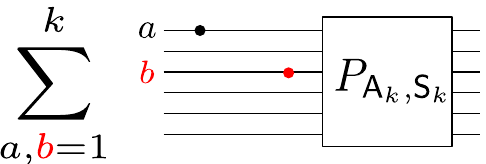
Figure 4. The operator that can be obtained by brining two ˜Φ 0 s together. It consists of k 2 terms and only k of them contains two ˜Φ’s on the same fundamental loop. Therefore, the leading term in the OPE is given by a two-particle operator, not a single-particle operator of ˜Φ 2